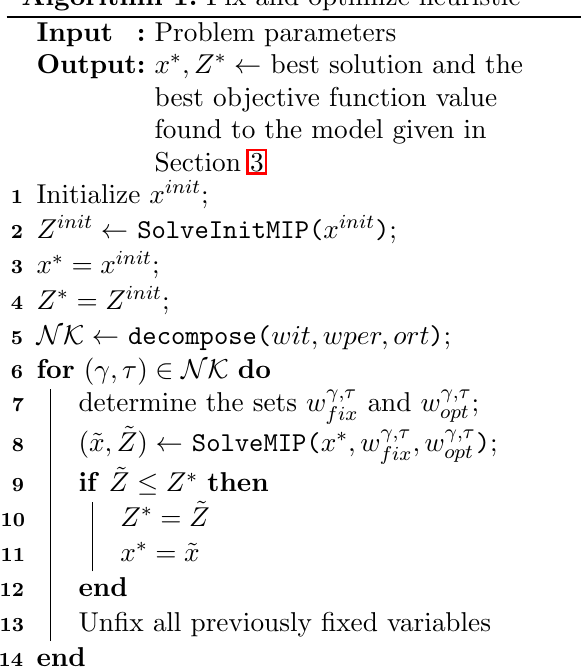
Algorithm 1: Fix-and-optimize heuristic